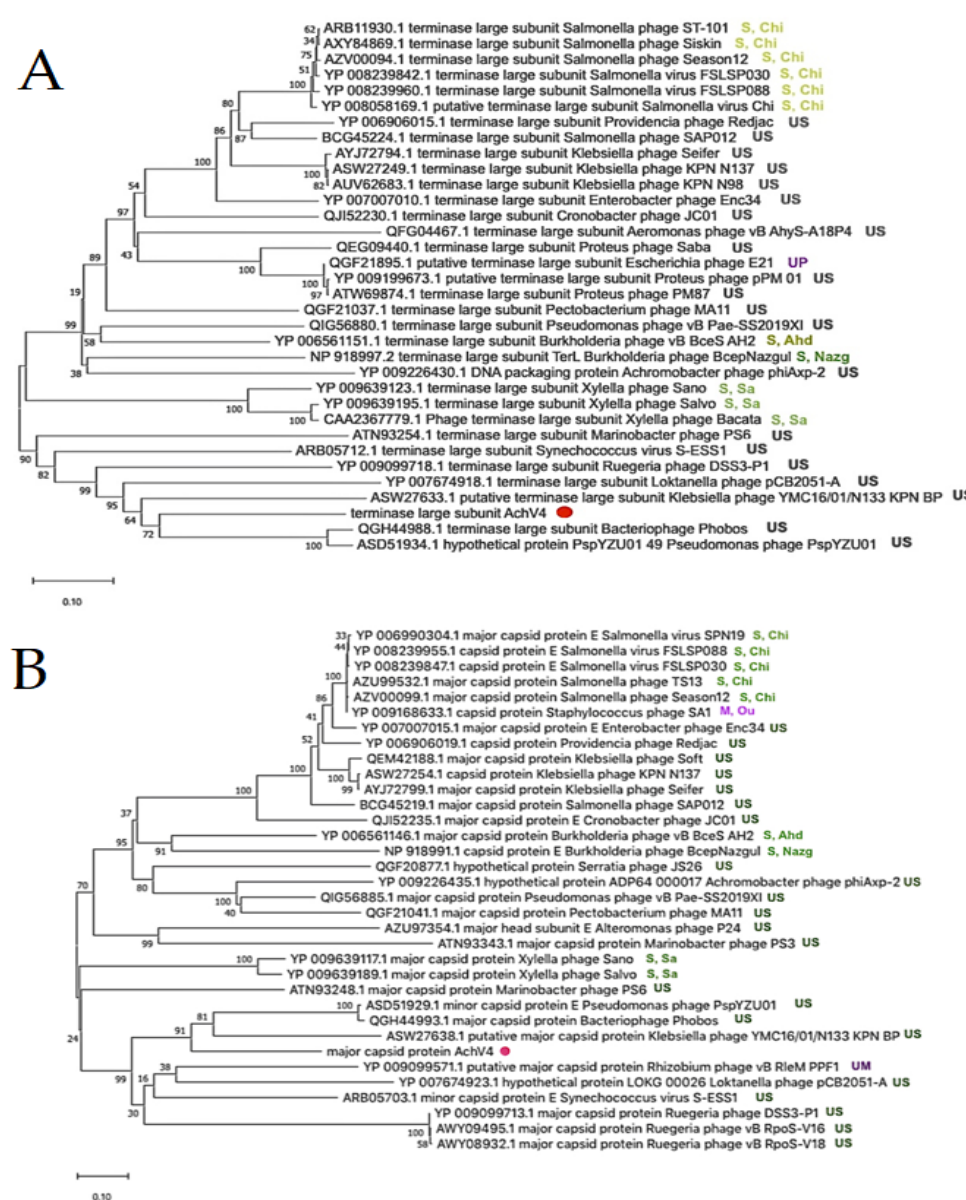
Figure 3. Phylogenetic analysis. Neighbor-joining tree analysis based on the ClustalW alignment of: the large terminase subunit ( A ) and the major capsid protein ( B ) sequences. The percentage of replicate trees in which the associated taxa clustered together in the bootstrap test (500 replicates) is shown next to the branches. Evolutionary analyses were conducted in MEGA X. US—unclassified siphovirus; UM—unclassified myovirus; UP—unclassified podovirus; S, Sa— Siphoviridae , Sanovirus ; S, Chi— Siphoviridae , Chivirus ; S, Ahd— Siphoviridae , Ahduovirus ; S, Nazg— Siphoviridae ; Nazgulvirus ; M, Ou— Myoviridae ; Ounavirinae ; AchV4 is indicated by a red dot.